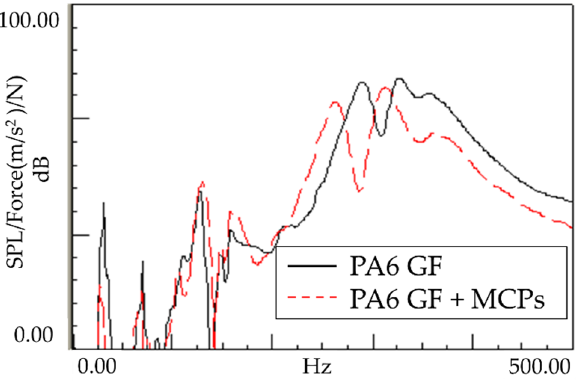
Figure 8. Effects of MCPs on the sound response of the plate specimen.